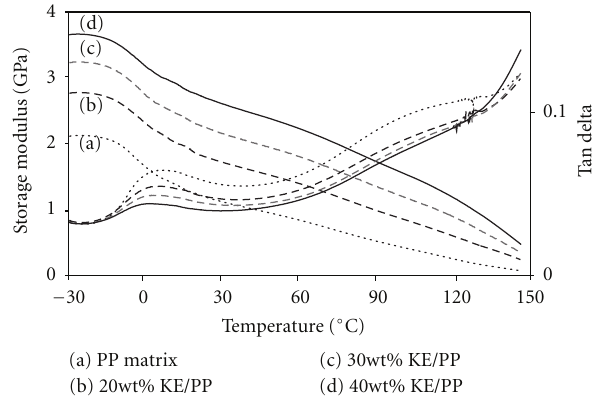
Figure 4: Storage modulus and tan delta of kenaf fiber/PP as a func- tion of fiber content and